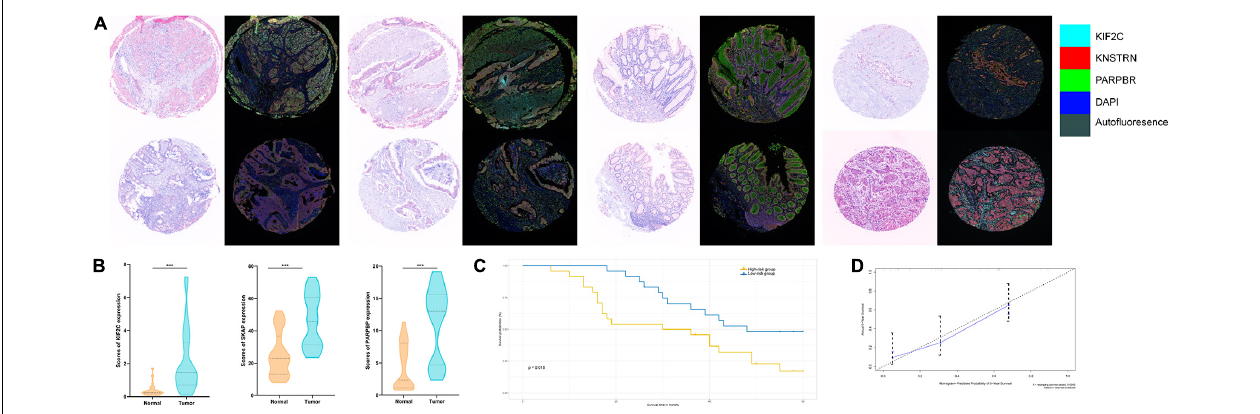
FIGURE 8 | (A) Tumor tissue and corresponding non-tumorous adjacent tissue were collected from colorectal cancer patients in TMAs. The expression of PARPBP (green), KNSTRN (red), and KIF2C (cyan) indicates the lipid droplets in tumor-infiltrating myeloid cells. Nuclei (blue) were stained using DAPI. The absolute number of positive cells was quantified in whole fields (hpf; scale bar = 20 lm). (B) Comparing the expression of PARPBP, KNSTRN, and KIF2C in tumor tissue and non-tumorous adjacent tissue based on the single index strength score (Student’s two-tailed t -tests, *** p < 0.001). (C) The Kaplan–Meier test of the risk score for the overall survival between the high-risk and the low-risk group (log-rank test, p < 0.05). (D) The calibration curves for identifying the consistency between actual observation and nomogram-predicted OS probabilities.